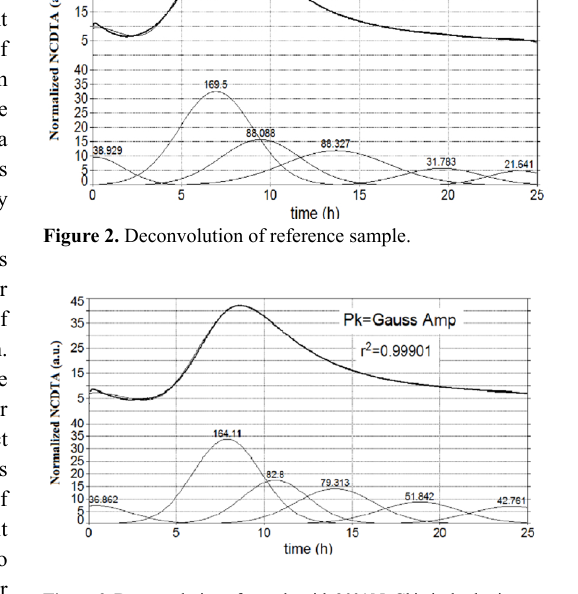
Figure 3. Deconvolution of sample with 20% NaCl in its hydration water. The curve situated at the top of the figures is the superimposition of the original curve and normalized NCDTA curve, representing the sum of the peak areas of Gaussian along the hydration time. The curves located at the bottom of the figures refer to the Gaussian peak areas generated with their respective areas in arbitrary